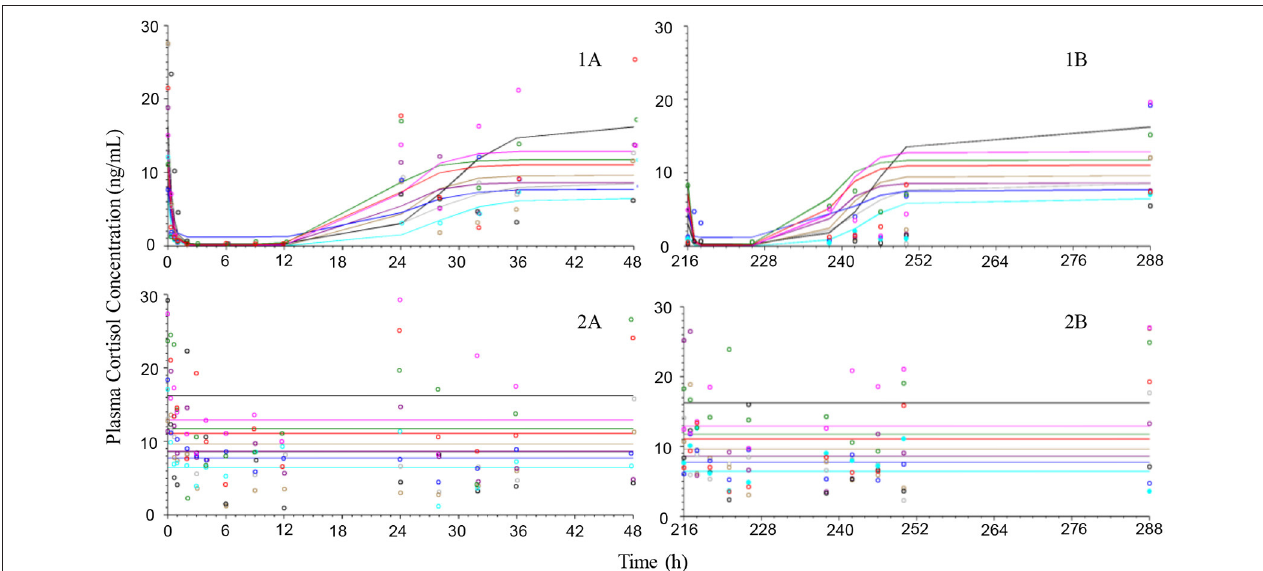
FIGURE 6 | Observed (symbols) and model predicted (lines) cortisol plasma concentration-time courses following intravenous administration (left plots) of 1 mg/kg prednisolone succinate (1A) or saline (2A) and after the last oral (right plots) dose (216h after first dose) of ∼ 1 mg/kg for 10 consecutive daily doses orally (1B) or placebo (2B) to 9 beagle dogs.